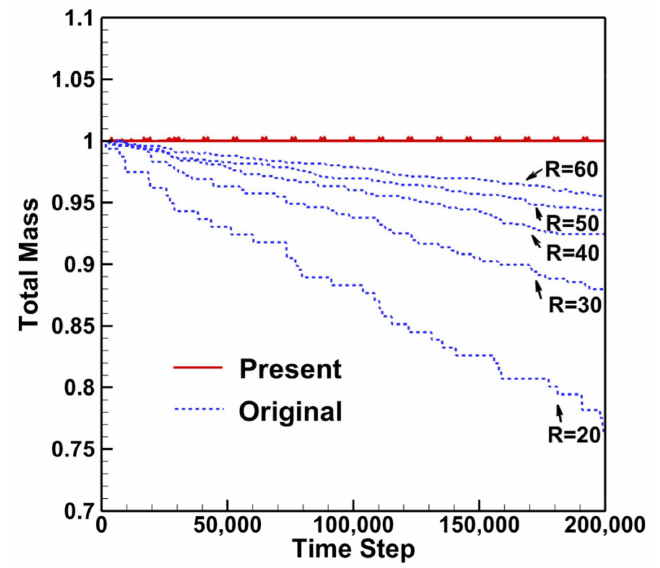
Figure 5. Variation in the mass for the bubble at σ =